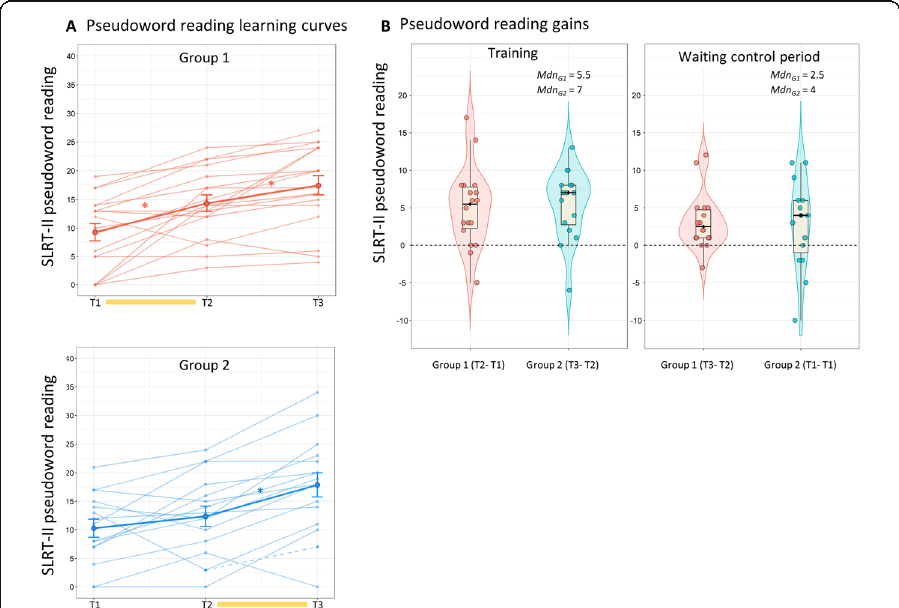
Fig. 1 Results for the SLRT-II pseudoword reading task. a Line plots show individual scores and group means across the 3-time points for group 1 (top) and group 2 (bottom). The training period for each group is indicated by a yellow bar in the x-axis. Dashed lines indicate children for which the data of one test time was missing, error bars indicate SEM and asterisks indicate significant t tests at p corr < 0.05. b Violin and box plots show delta scores for each group during the training period (left) and waiting control period (right). Black horizontal bar indicates the median. Data from group 1 are shown in red and data from